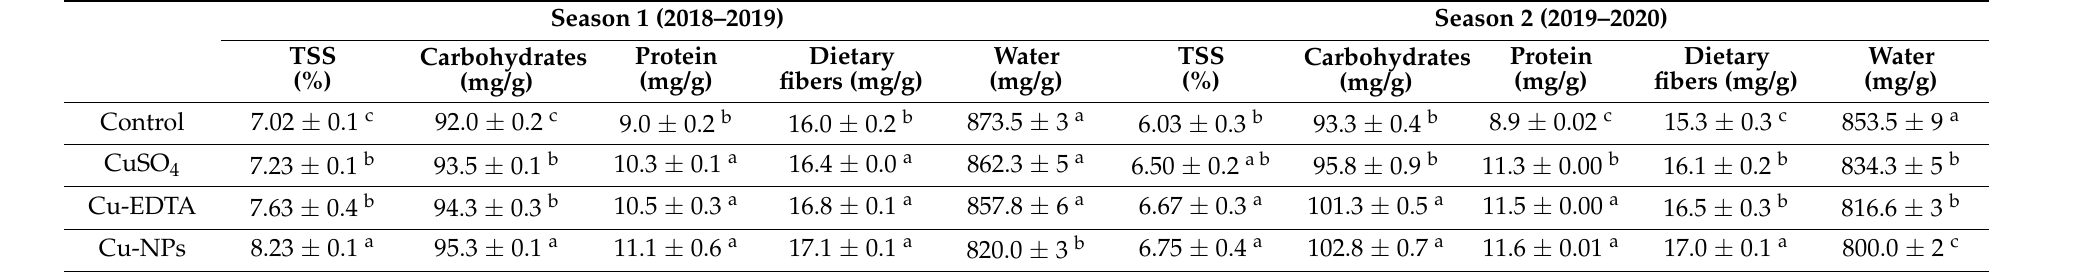
Each value represents the mean ± standard error. Values with different letters show significant differences at p ≤ 0.05 (Duncan’s Test). Table 9. Effect of different sources of Cu on vitamin contents of onion in two seasons (2018/2019 and 2019/2020).